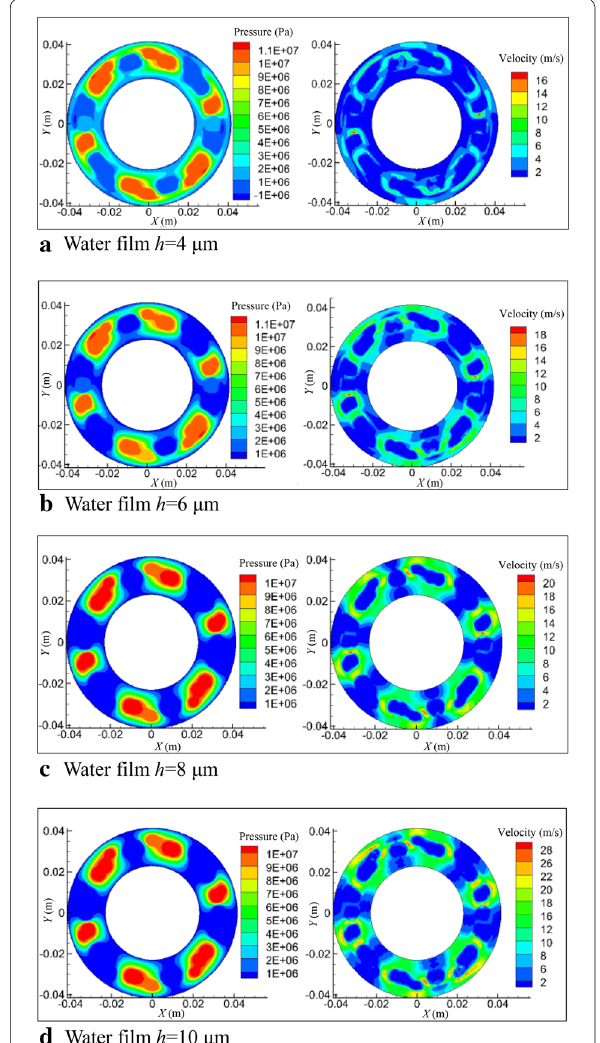
Figure 10 Pressure and velocity contour of flow distribution water film